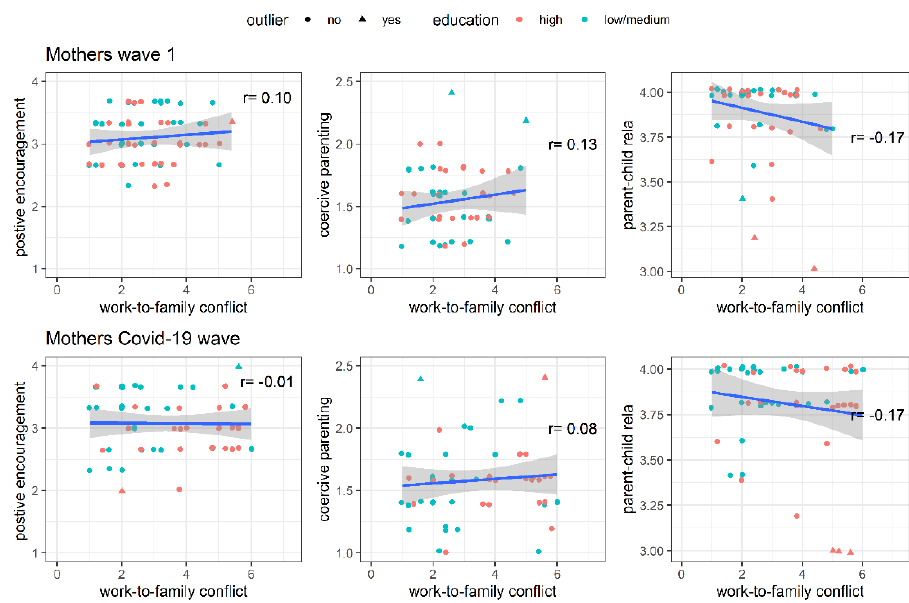
Figure A.2 W → F-conflict and perceived parenting for